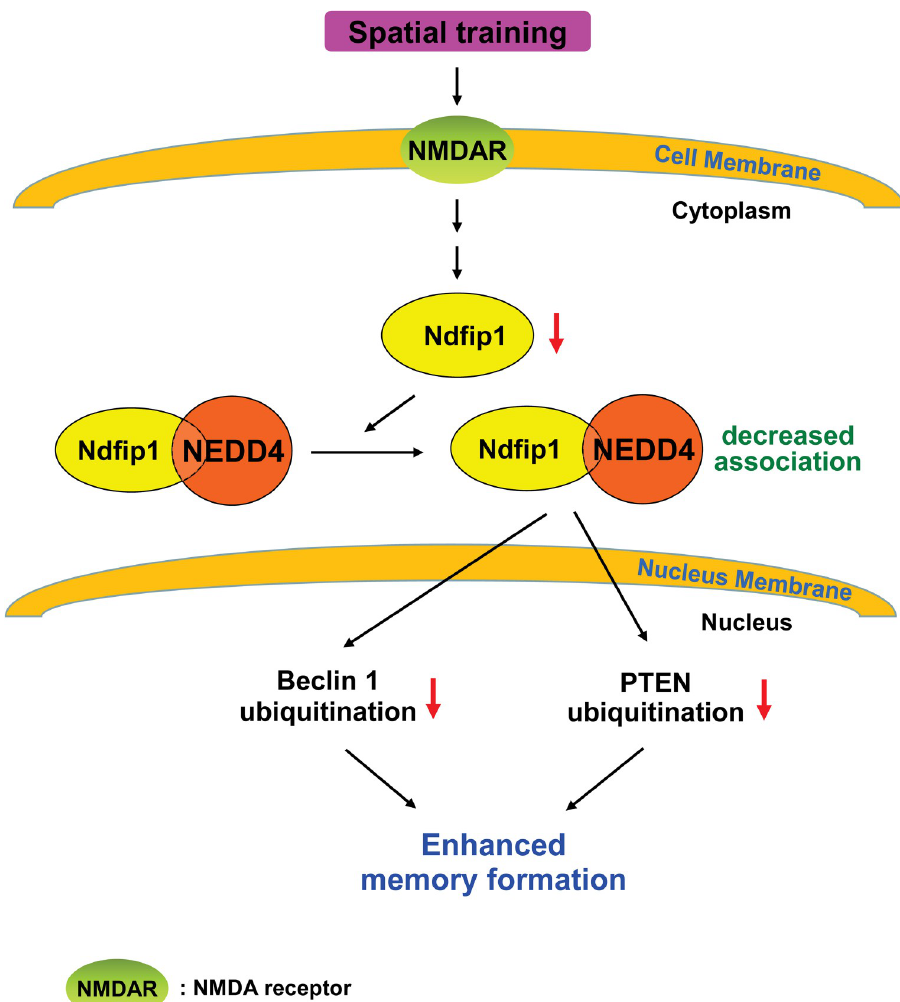
S1 Fig. Acute NMDA administration decreases Ndfip1 expression in rat hippocampus. S2 Fig. The swim speed for probe trial performance and visible platform learning perfor- mance of three genotypes of mice. S3 Fig. Beclin 1 is an ubiquitination target of Nedd4 and Beclin 1 ubiquitination is decreased by Ndfip1 siRNA in HEK293T cells. S4 Fig. PTEN is an ubiquitination target of Nedd4 and PTEN ubiquitination is decreased by Ndfip1 siRNA in HEK293T